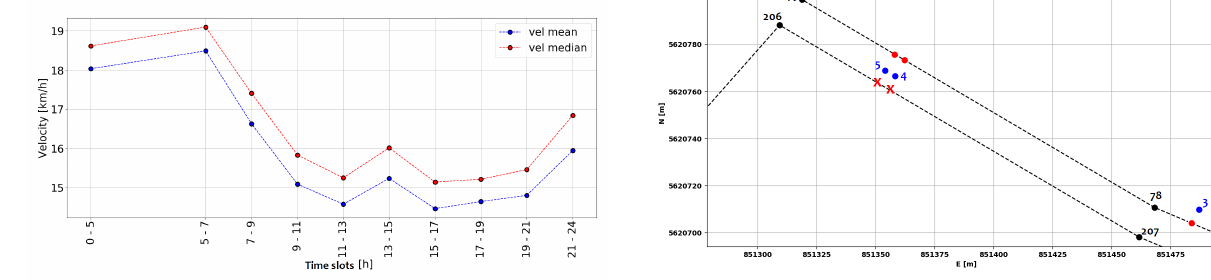
Figure 13. Network projection strategy: in black the line network, in blue the original FCD points, in red the corresponding projections within the line network: the cross markers represent the wrong projections, the dot markers represent the right